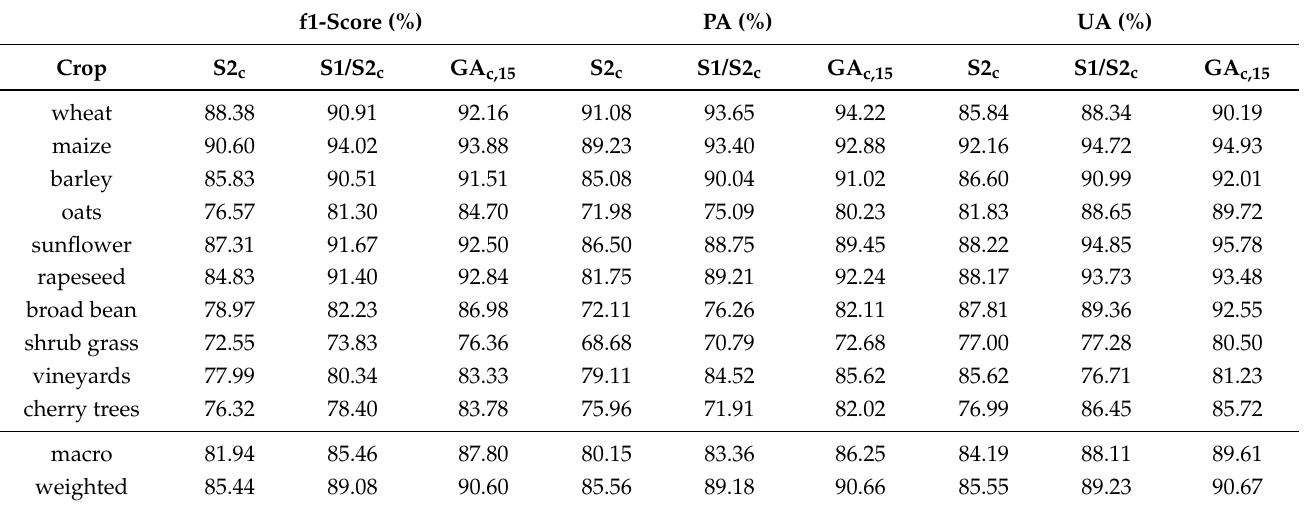
Table 5. UA, PA, and f1-score of the SVM model when trained (i) only on the artificially-clouded Sentinel-2 time-series (S2 c model), (ii) both on the artificially-clouded Sentinel-2 time-series and the Sentinel-1 PolSAR time-series (S1/S2 c model), and (iii) on the 120 features derived when used 15 as threshold (GA c,15 ). f1-Score